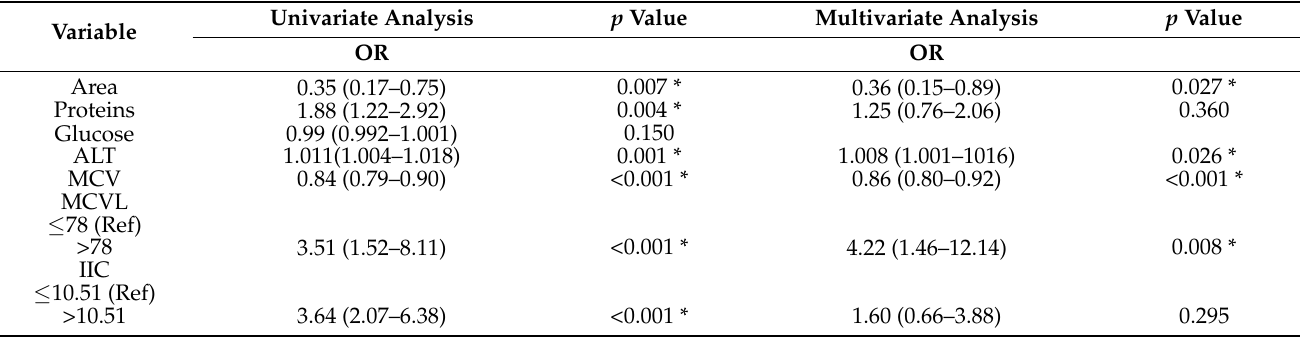
Table 10. Univariate and multivariate analyses of variables associated with complications in peri- COVID